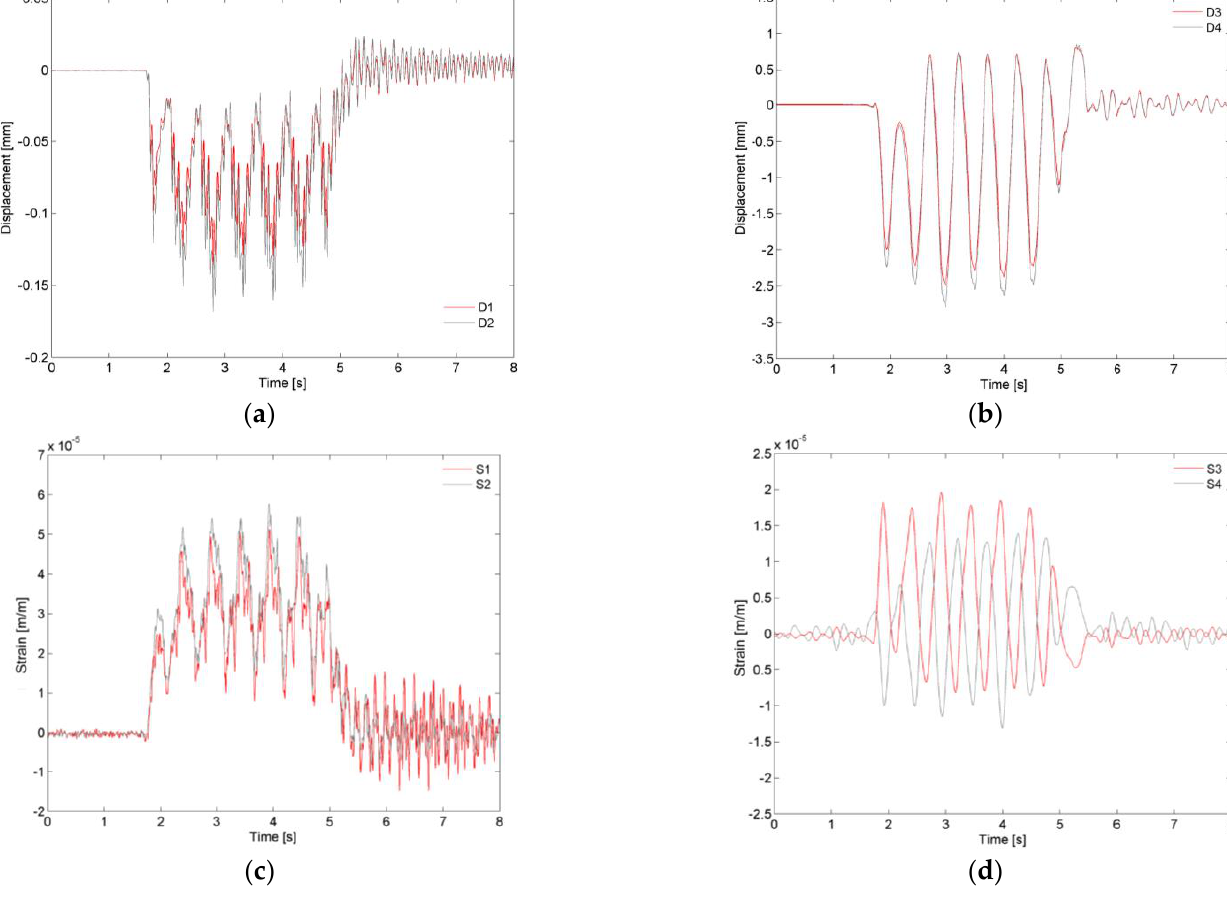
Figure 16. Experimental records of the passage of the Alfa Pendular train at a speed of 180 km/h: ( a ) displacement of the supports; ( b ) displacement of the main girder and deck slab; ( c ) strain of the hangers P3; ( d ) strain of the main girder and rail.